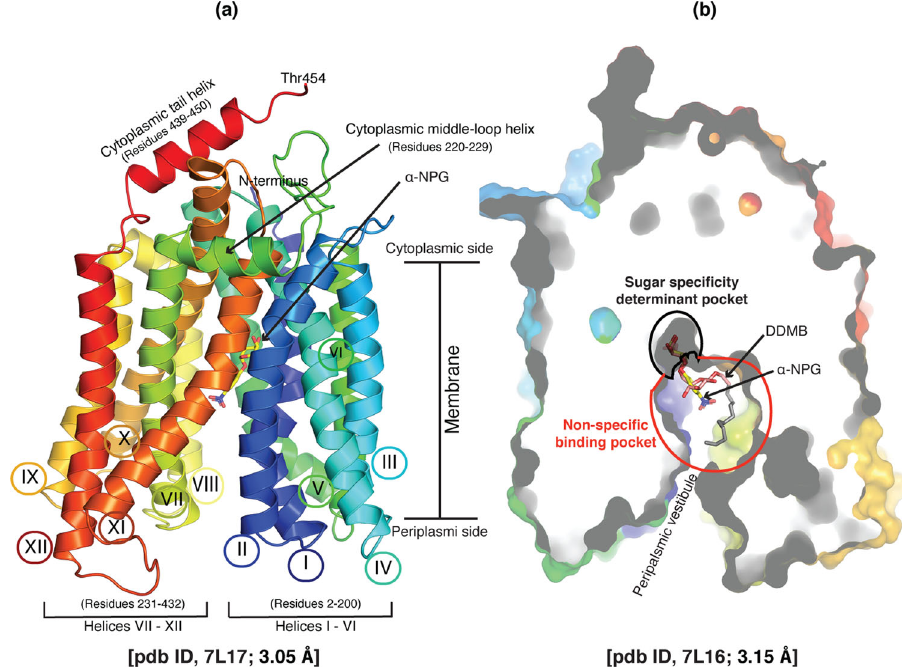
Fig. 2 X-ray crystal structures of D59C MelB St with bound α -NPG or DDMB. a Overall fold and helical packing [PDB ID, 7L17]. The D59C MelB St structure with bound α -NPG is viewed parallel to the membrane and shown in cartoon representation, which is colored in rainbow from N-terminus in blue to C-terminal end in red. Both termini are located in the cytoplasmic side as indicated. The membrane-spanning region is proximately estimated and indicated. Transmembrane helix is numbered in Roman numerals, and the two cytoplasmic helices is named as cytoplasmic middle-loop helix or cytoplasmic tail helix. The amino-acid sequence positions for the N-terminal 6 helices (I-VI) and the C-terminal 6 helices (VII-XII), as well as the two cytoplasmic helices, are indicated. The bound α -NPG is indicated. b Outward-facing conformation with bound DDMB [PDB ID, 7L16]. The structure is shown in a cross-section of surface representation with the N-terminal bundle orientated at the left side. DDMB is shown in pink and tail (C2-12) in gray. The sugar speci fi city determinant pocket is indicated by a black cycle, and the non-speci fi c binding pocket is indicated by a red cycle. A α -NPG molecule was included that was from the α -NPG-bound structure [7L17] after overlayed with the DDMB-bound structure. PDB identi fi cation code for both structures are